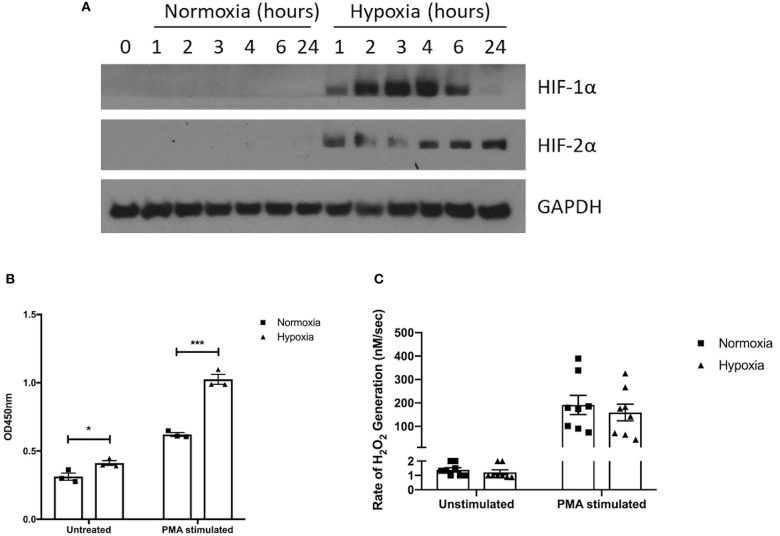
Hypoxia enhances NET release but not hydrogen peroxide production. The effects of hypoxia upon neutrophil activation was first assessed. (A) The induction of hypoxia was verified by Western blot, probing for HIF-1α and HIF-2α. (B) NET formation was then evaluated by capture ELISA, which detects MPO-citrullinated histone H3 complexes. Data are presented as the mean ±SEM from three different donors and analyzed by two-way ANOVA with a Dunnett's multiple comparison test. (C) Hydrogen peroxide generation was examined using Amplex® UltraRed in absence and presence of 50 nM PMA. Data are presented as the mean ± SEM from neutrophils isolated from seven different donors and analyzed by two-way ANOVA with a Dunnett's multiple comparison test. * = p < 0.05, *** = p < 0.001. HIF, hypoxia-inducible factor; PMA, phorbol 12-myristate 13-acetate.